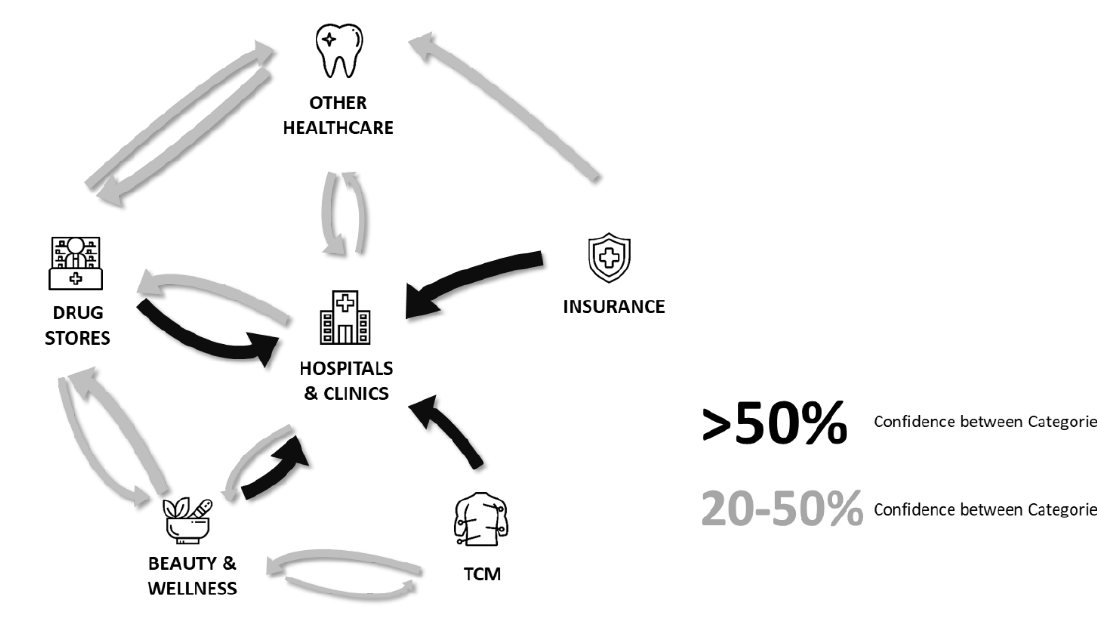
Figure 7. Associations between healthcare-related merchant categories.